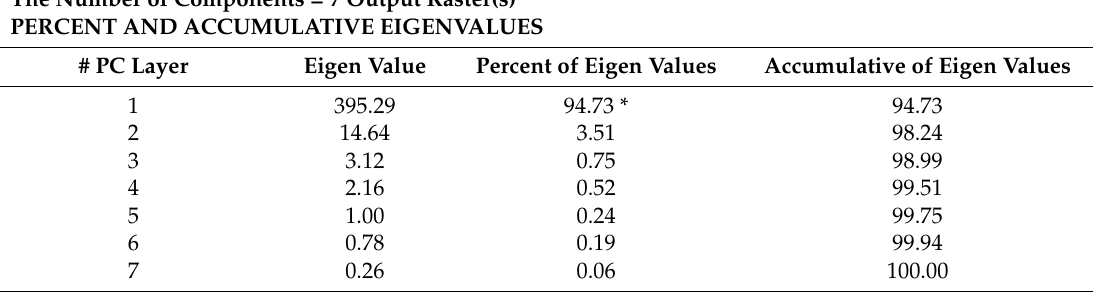
Table 3. PCA results to provide decision support for using fewer images in model development. The Number of Components = 7 Output Raster(s) PERCENT AND ACCUMULATIVE EIGENVALUES # PC Layer Eigen Value Percent of Eigen Values Accumulative of Eigen